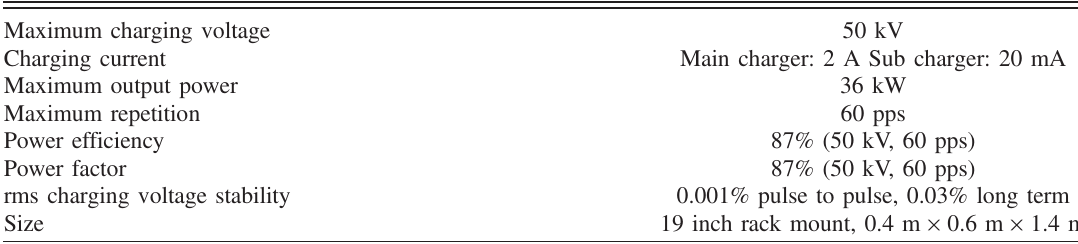
TABLE IV. Specifications of the high-voltage charger.